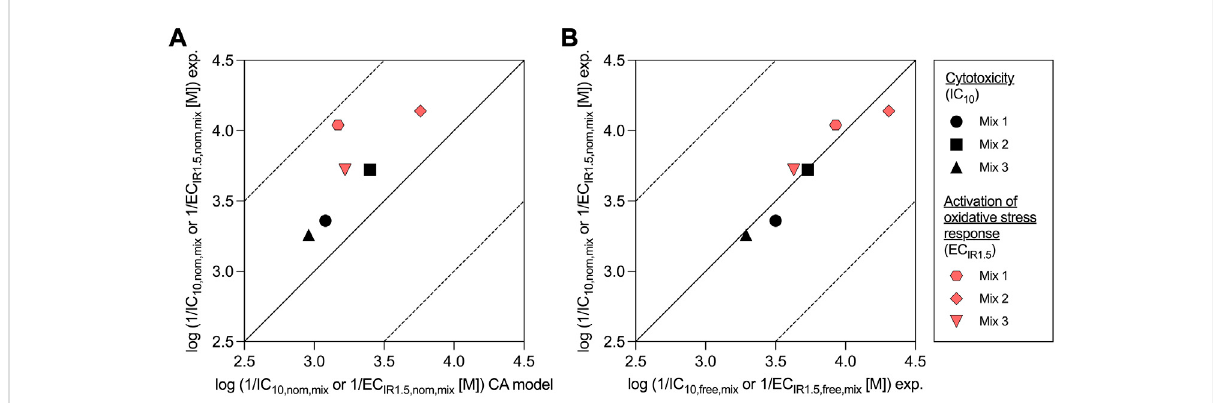
FIGURE 2 Comparison of experimentally derived (exp.) nominal effect concentrations of the mixtures for cytotoxicity (IC 10,nom,mix ) and activation of oxidative stress response (EC IR1.5,nom,mix ) with (A) predicted values from the concentration addition (CA) model and (B) with experimentally derived (exp.) freely dissolved effect concentrations (IC 10,free,mix and EC IR1.5,free,mix